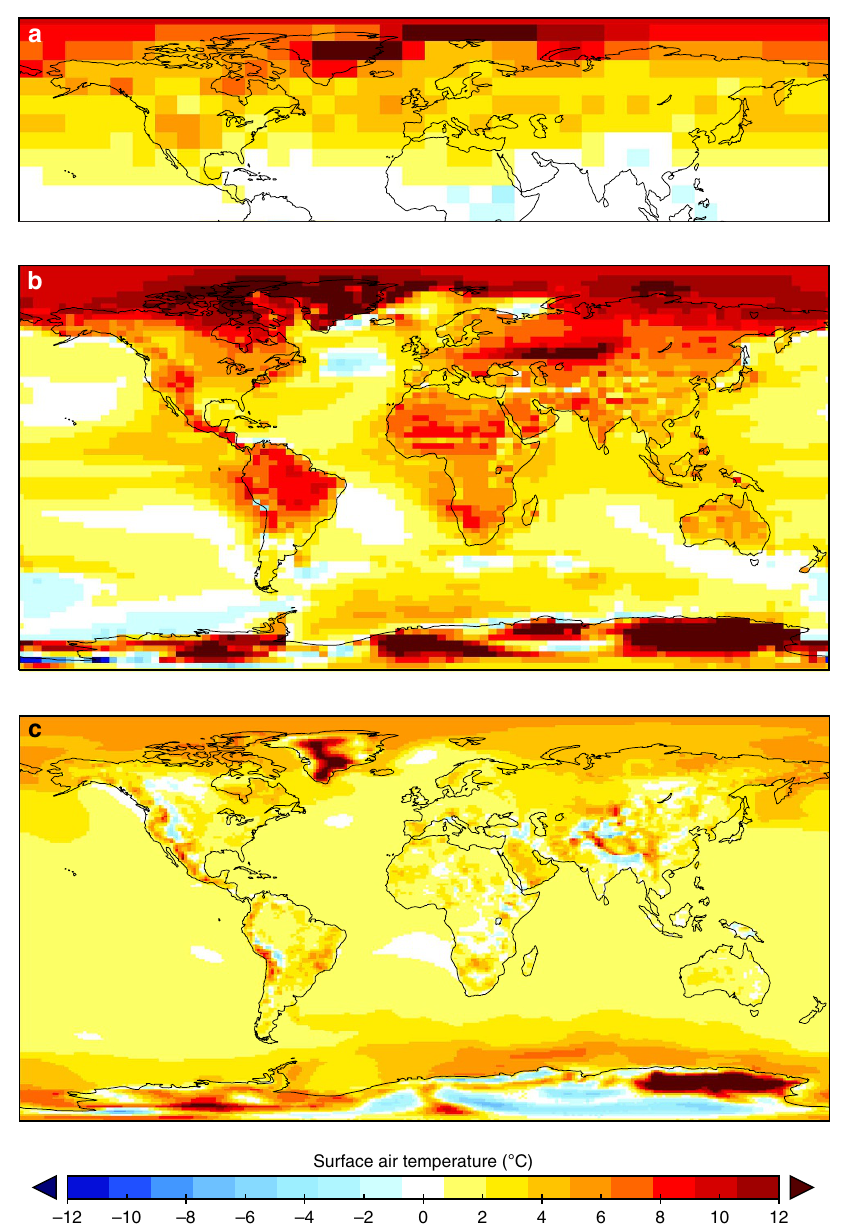
Figure 4 | Evolution of climate simulations. Pliocene surface air temperature simulations. ( a ) Goddard Institute for Space Studies (GISS) Atmosphere-only climate model with PRISM prescribed boundary conditions 22 . ( b ) Hadley Coupled Climate Model Version 3 simulation initiated with PRISM2 boundary conditions 66 . ( c ) Community Climate Model Version 4 simulation initiated with PRISM3D boundary conditions 113